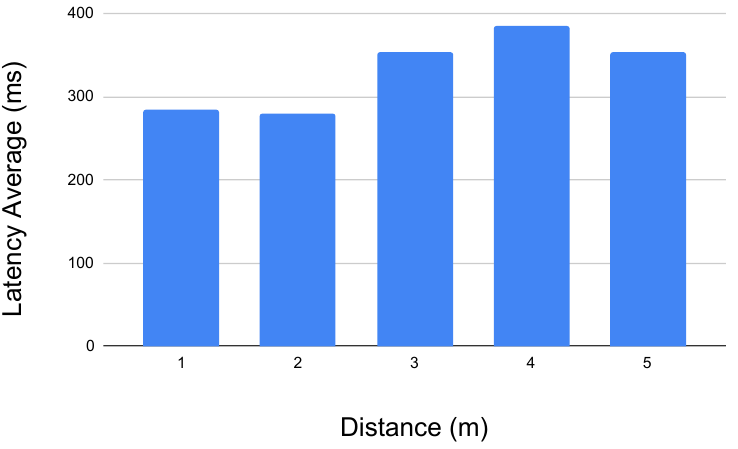
Figure 33. Latency results obtained by teleoperating the robot with a scripting GUI via the on-board HTTP Android